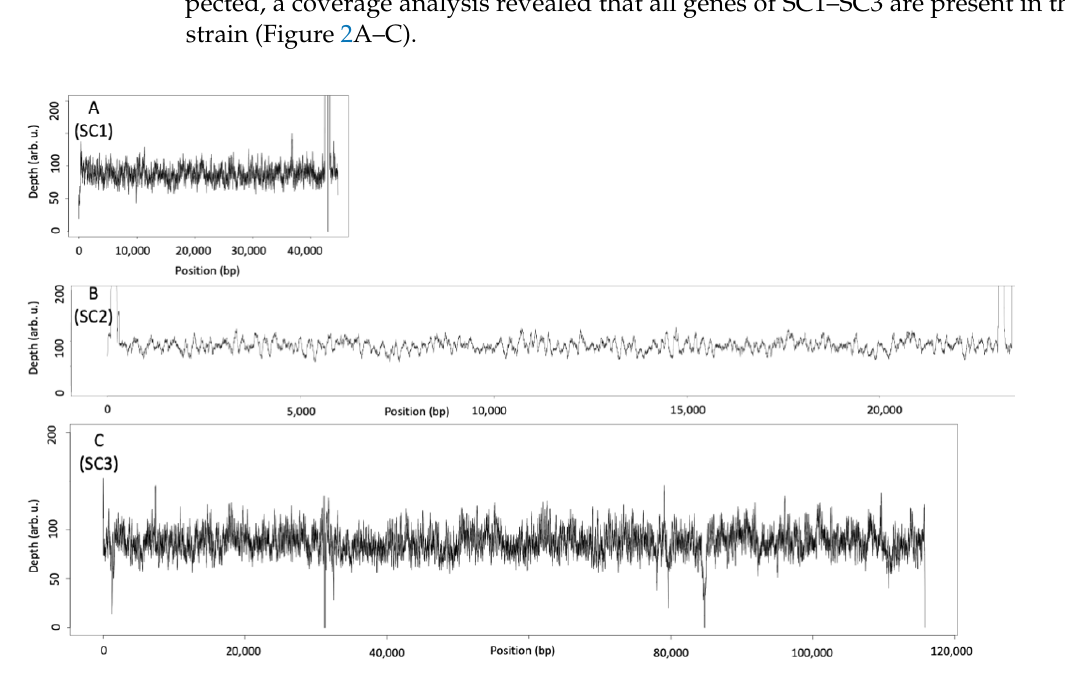
Figure 2. Coverage analysis of deep resequencing sequences of IBT 40293 with accession numbers KL650302, KL651028, and KL652499 (representing the ( A ) SC1, ( B ) SC2, and ( C ) SC3 of IBT 40293, respectively).